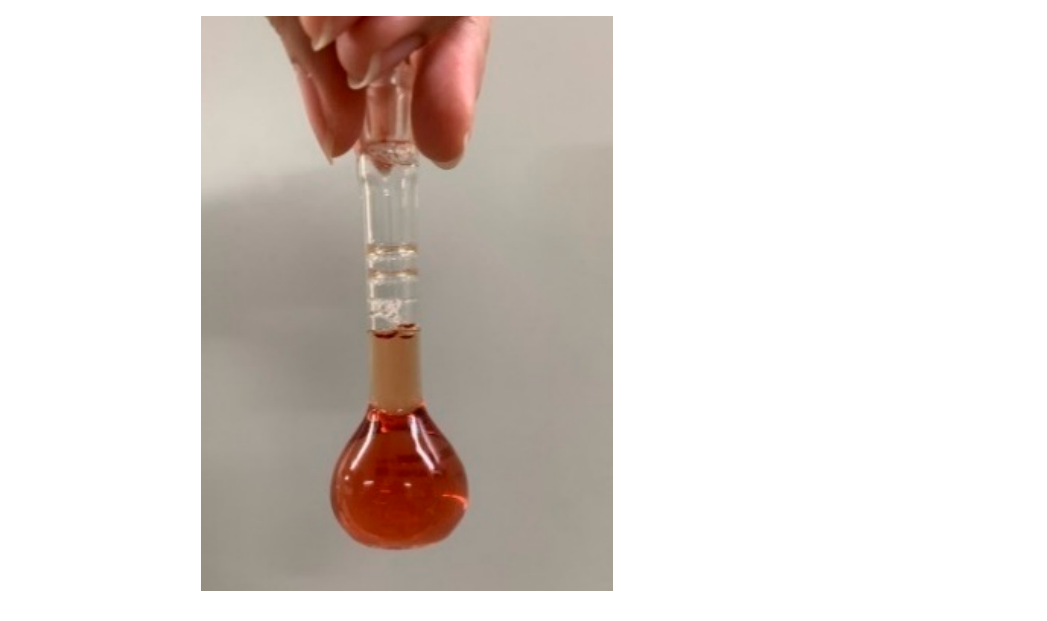
Figure 7. 20 mL of cyanmethemoglobin standard solution in a volumetric flask. Lastly, for the diluted cyanmethemoglobin standard solution, the solution can be cre- ated by mixing Drabkin’s solution with cyanmethemoglobin standard solution at different concentrations, as shown in Table 1. The decreased concentration of hemoglobin is needed to provide a calibration curve for hemoglobin concentration. Table 1. Diluted cyanmethemoglobin standard solution at different concentrations. Tube No.